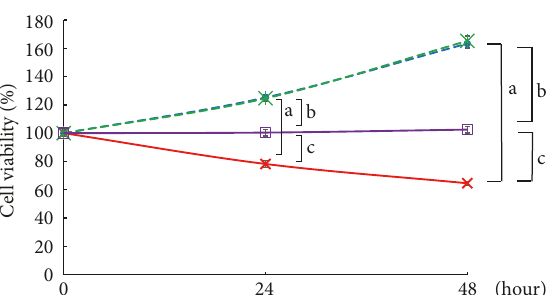
Figure 2: Cell viability by TNF- 𝛼 stimulation. Cells were treated with 20 ng/mL TNF- 𝛼 for either 24h or 48 h. Cell viability at 0h was taken as 100%. Blue circle: Mock untreated; red cross: Mock TNF- 𝛼 ; green asterisk: TERT HUVEC R untreated; purple square: TERT HUVEC R TNF- 𝛼 ; n=3; a = P < 0.01; Mock untreated versus Mock TNF- 𝛼 ; b = P < 0.01, TERT HUVEC R untreated versus TERT HUVEC R TNF- 𝛼 ; c = P < 0.01, Mock TNF- 𝛼 versus TERT HUVEC R TNF- 𝛼 .